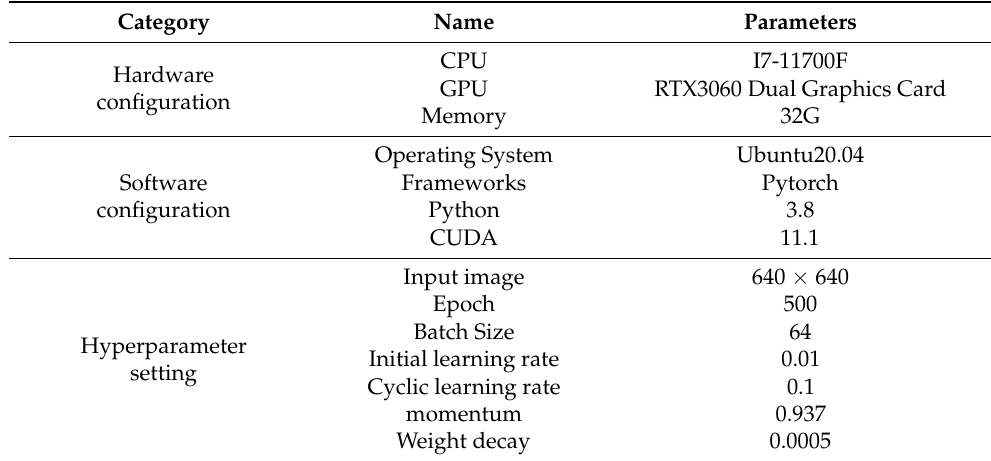
Table 4. Development platform information.